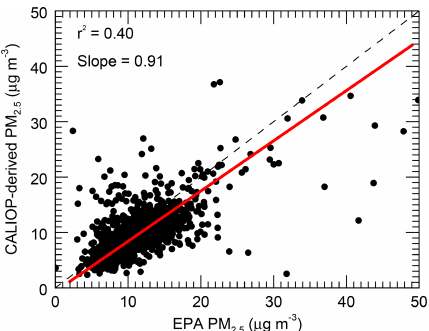
Figure 4. Scatter plot of mean PM 2 . 5 concentration from ground- based U.S. EPA stations and those derived from collocated near- surface CALIOP observations using combined daytime and night- time CALIOP data. The red line represents the Deming regression fit.